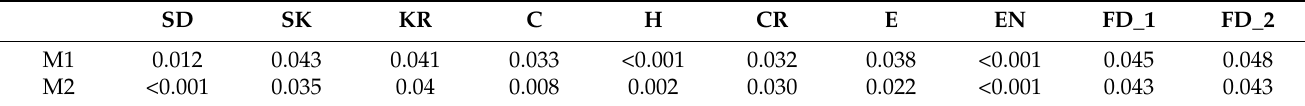
Table 1. The p -value from t-test computed for first, second and FD